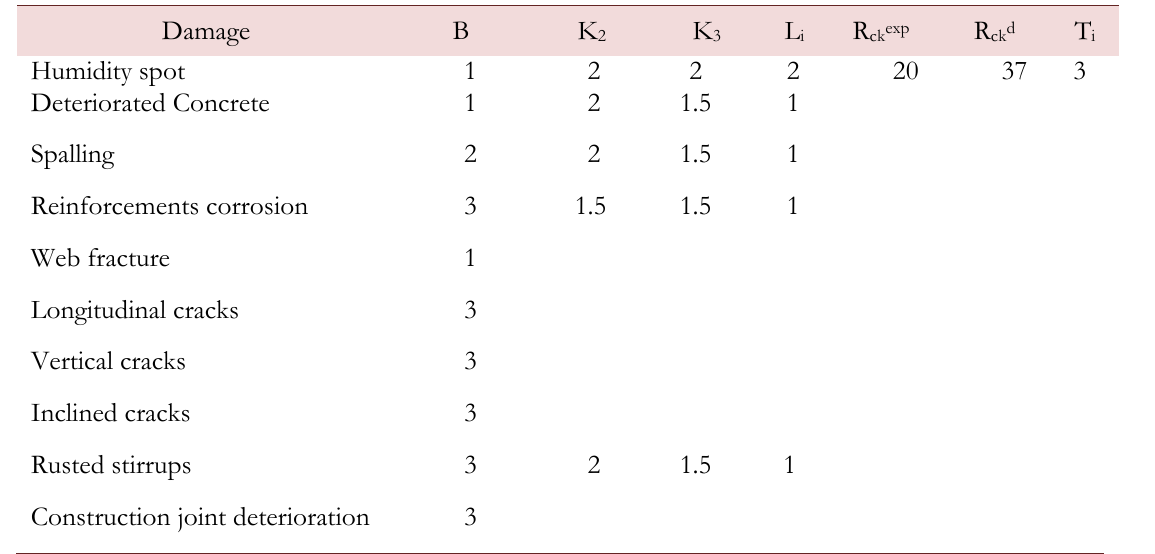
Table 8: Slab Damage identification form for bridge P08.